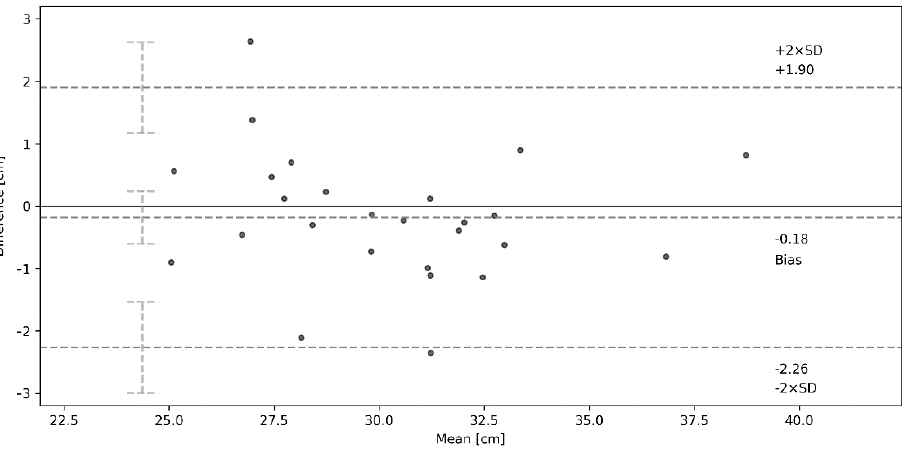
Figure 5. Force plate vs. IMU measuring CMJ height agreement (Bland-Altman plot).